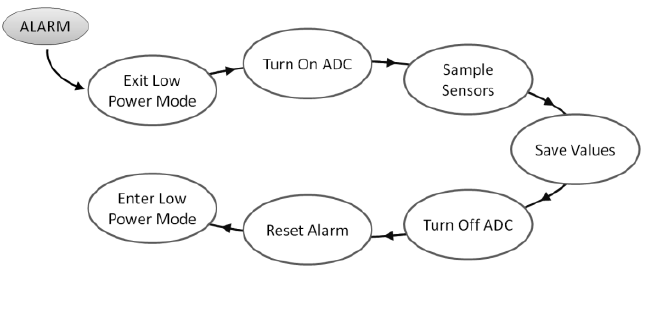
Figure 7. Sensor sampling